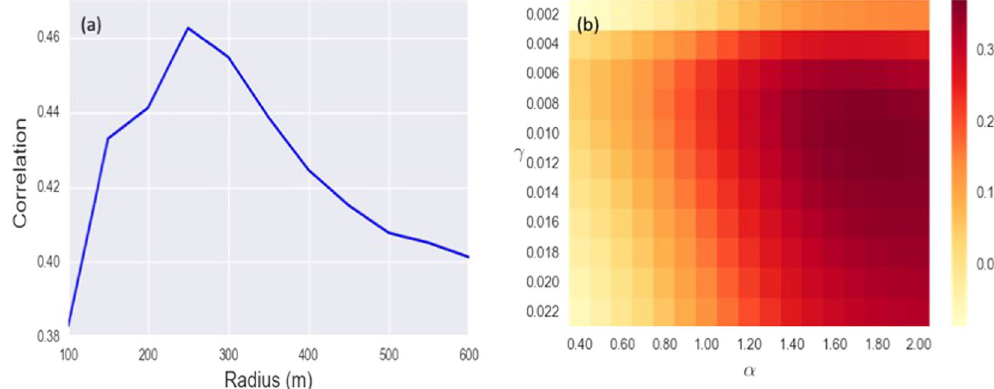
Figure 3. In the left panel in ( a ), we show the correlation between the rateable value of retailers in the VOA dataset, and the check-ins found in Foursquare around them for different radii. We can see how the correlation peaks at R = 250 m . In the right panel in ( b ) we show the correlation between the expected turnovers Y ( α , γ ) of each shop and the number of check-ins measured within a radius of R = 250 m from it. The set of parameters that maximize the correlation are α max , γ max = (1.8, 0.01), which are quite similar to what we found for the VOA rateable